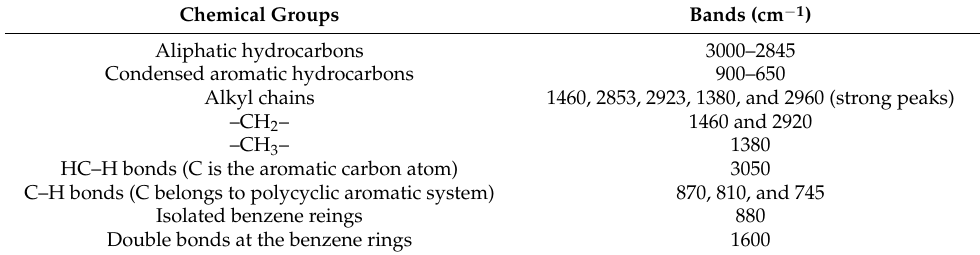
Table 4. Chemical deciphering the IR spectrum of the gasoil.